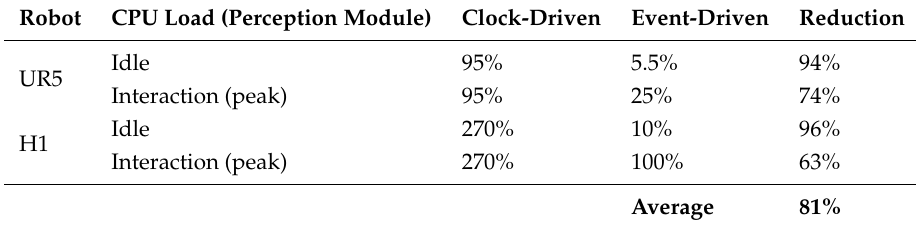
Figure 7. Network traffic and CPU load of the perception module of our e-skin system on one UR5 arm with 253 deployed skin cells (125 Hz sampling clock) [93] and on H1 with 1260 deployed skin cells (250 Hz sampling clock) [40]; the idle e-skin system does not register any tactile interactions; any interaction with the e-skin generates information rate peaks that mirror to event rate peaks and thus to peaks with the network traffic or the CPU load; tactile interactions vary during our experimental setups; they range from stroking, hammering, reactive control (contact avoidance) [39,93] to